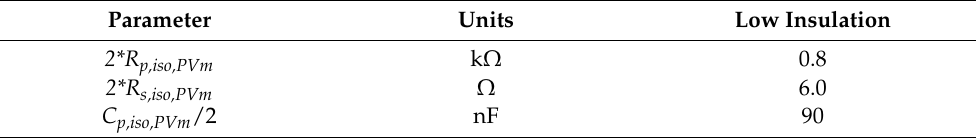
Table 5. Value setting adopted for parameters in simulations at low insulation condition. Parameter